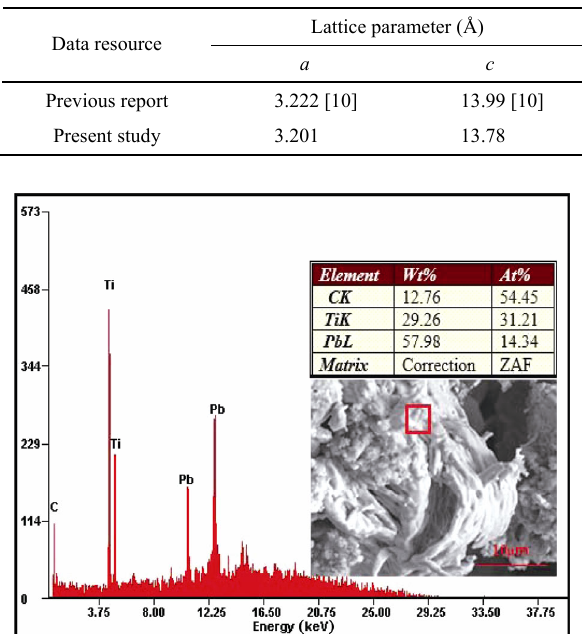
℃ Fig. 4 EDS spectra from the marked area of sample